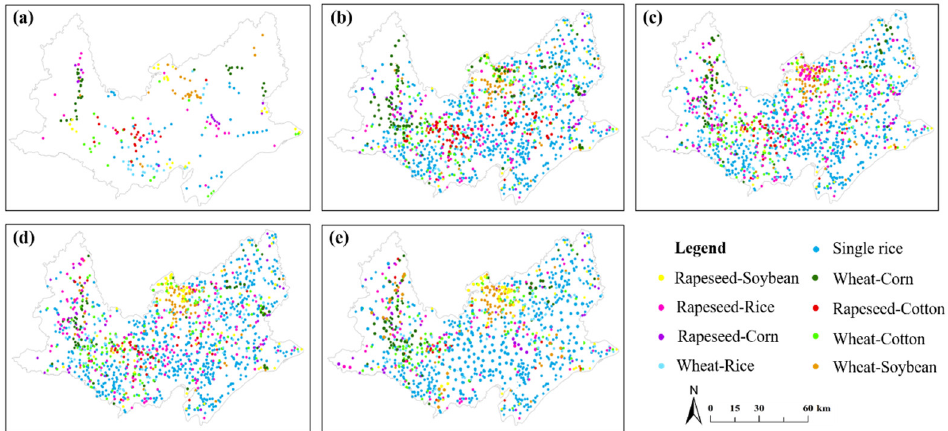
Figure 6. Multi-year sample points including the ( a ) field sampling points; ( b ) 2017–2018 sample set obtained through the sample migration strategy; ( c ) 2018–2019 sample set obtained through the sample migration strategy; ( d ) 2019–2020 sample set obtained through the sample expansion strategy; and ( e ) 2020–2021 sample set obtained through the sample migration strategy.